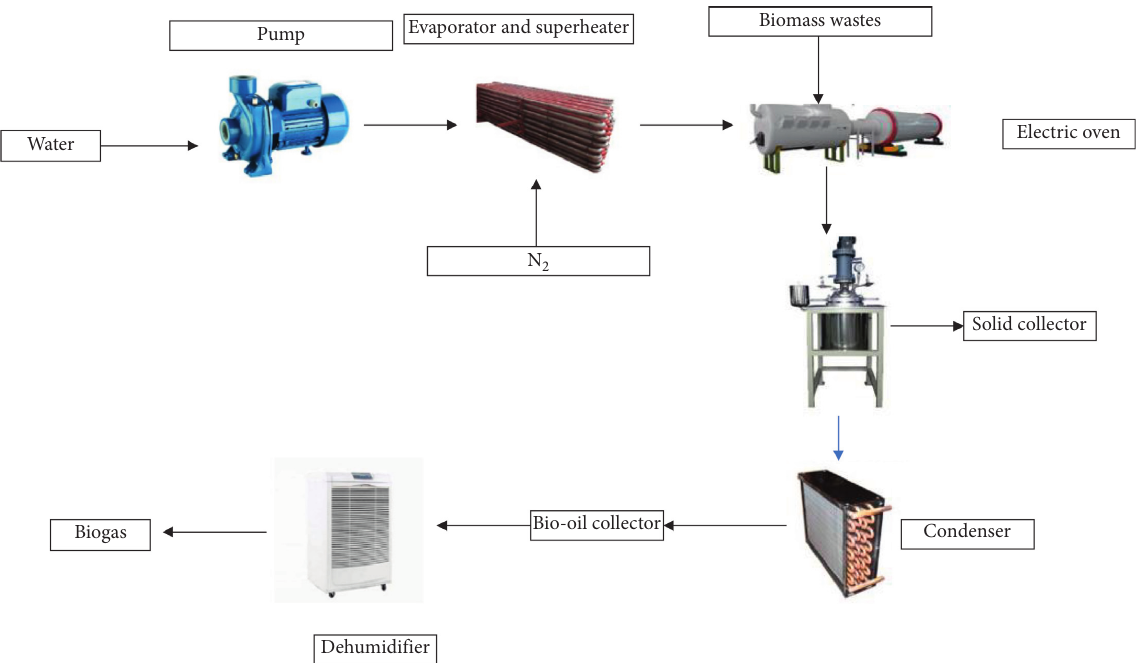
Figure 3: Schematic process of the BSP